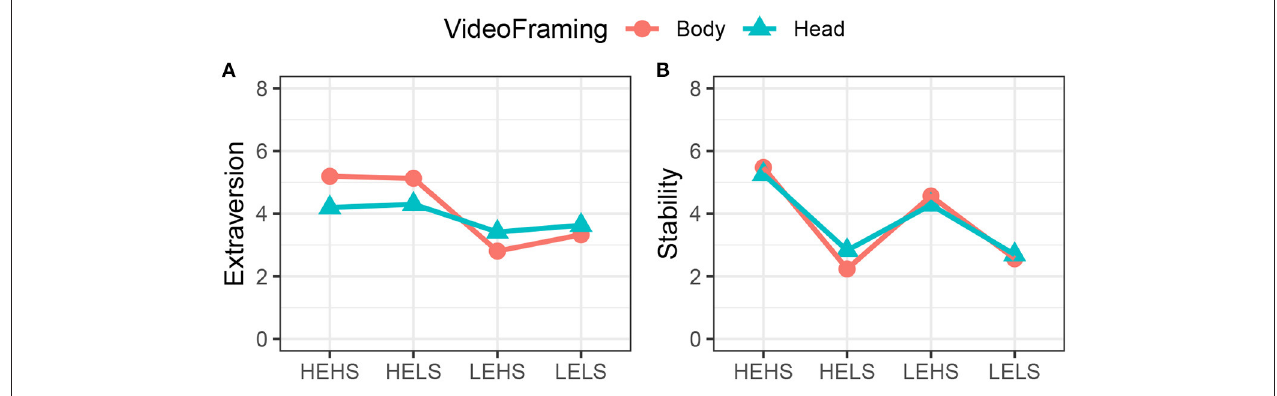
FIGURE 11 | Comparison of video framing (head-only vs. full-body) in the passive experiment. Extraversion (A) and Stability (B)